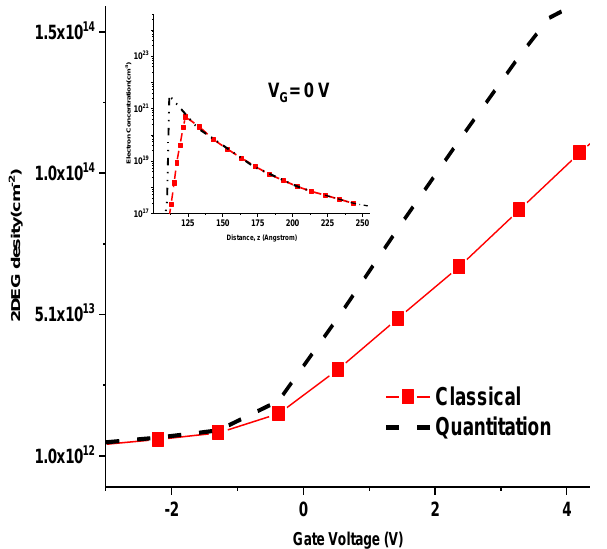
Figure 7. The gate voltage dependence of the 2DEG density for a generic InAlN/AlN/GaN using classical model (Equation (16)) and quantum mechanical (Equation (11)). The inset presents the electron distribution within the heterostructure at V g = 0V. The extracted parameters used in calculation are given as: V off = − 3.3V, C eff = 8.36 × 10 − 6 F/cm 2 , N c = 2.3 × 10 18 cm − 3